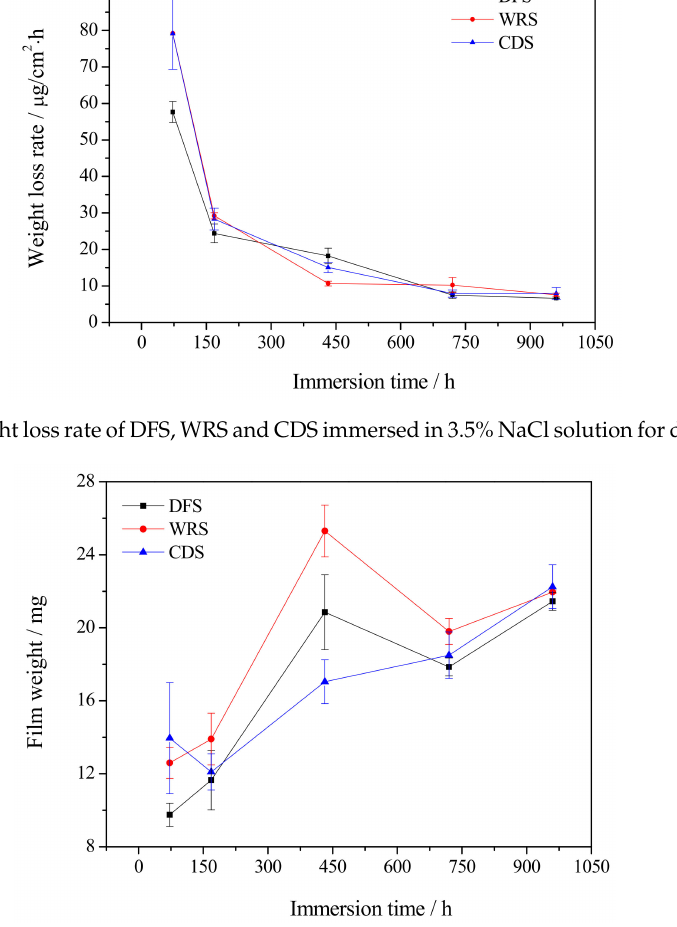
Figure 5. The film weight of DFS, WRS and CDS immersed in 3.5% NaCl solution for di ff erent